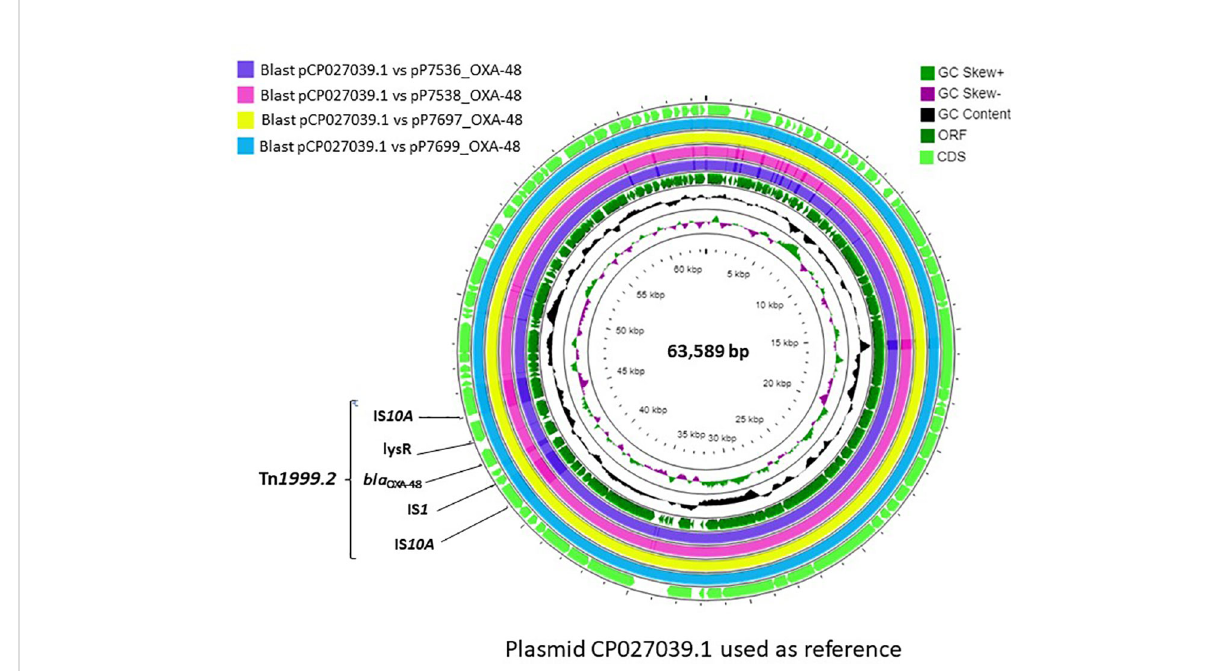
FIGURE 2 Genetic environment of the bla OXA-48 gene and circular representation of the complete OXA-48